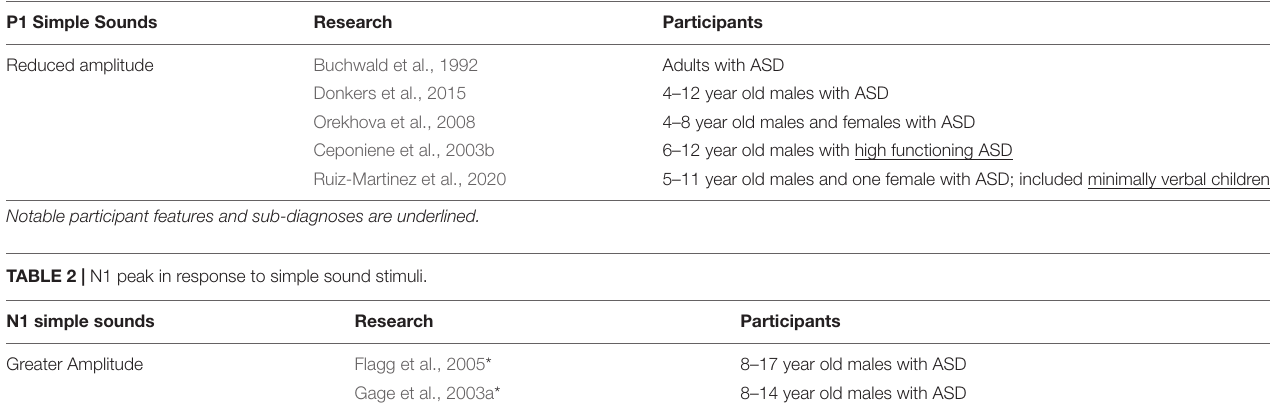
TABLE 1 | P1 peak amplitude in response to simple sound stimuli.